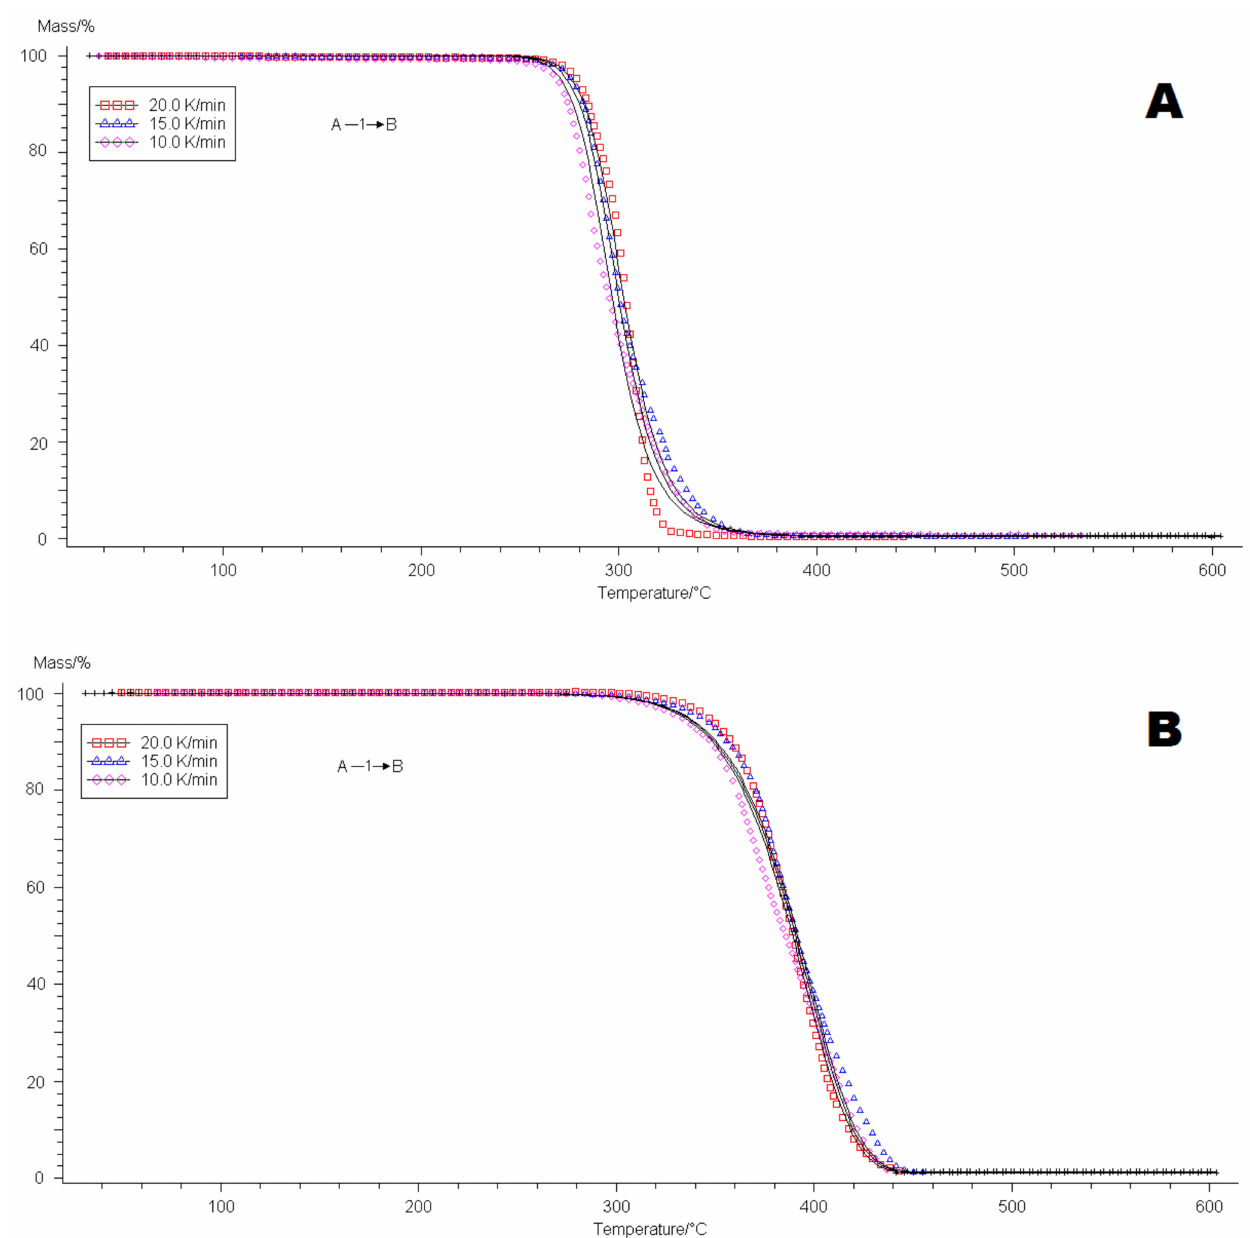
Figure A7. Experimental points for POM-P sample, investigated with 10, 15, and 20 ◦ C/min heating rates, represented by simulated solid lines: ( A ) investigations carried out in oxygen atmosphere; ( B ) investigations carried out in inert atmosphere. For the simulation, the apparent activation energy was used as the function of